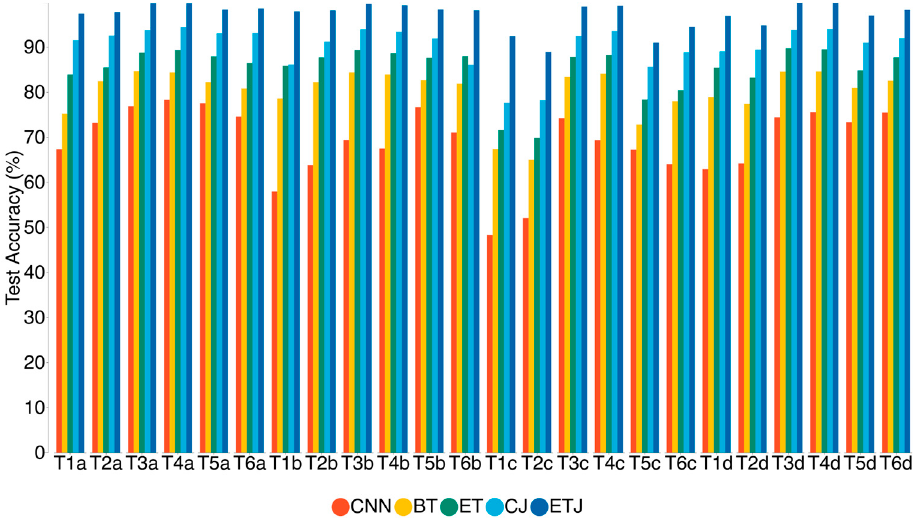
Figure 6. Diagnosis accuracy of Table 5 in a histogram.